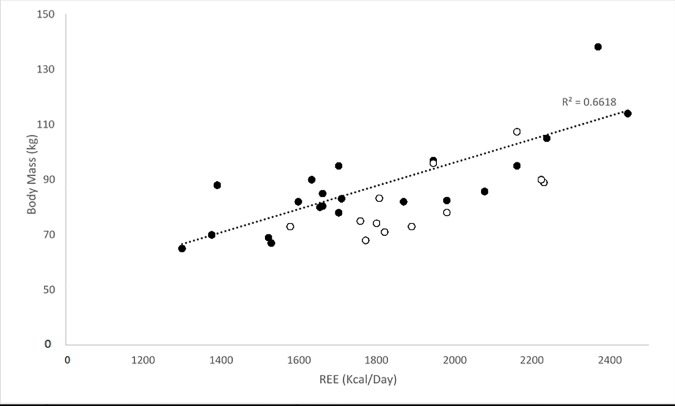
REE and Body Mass (Kg) relationship in BeMD (closed circles) and Control (open circles) participants.Kg = Kilograms; REE = Resting Energy Expenditure; Kcal = Kilocalories.